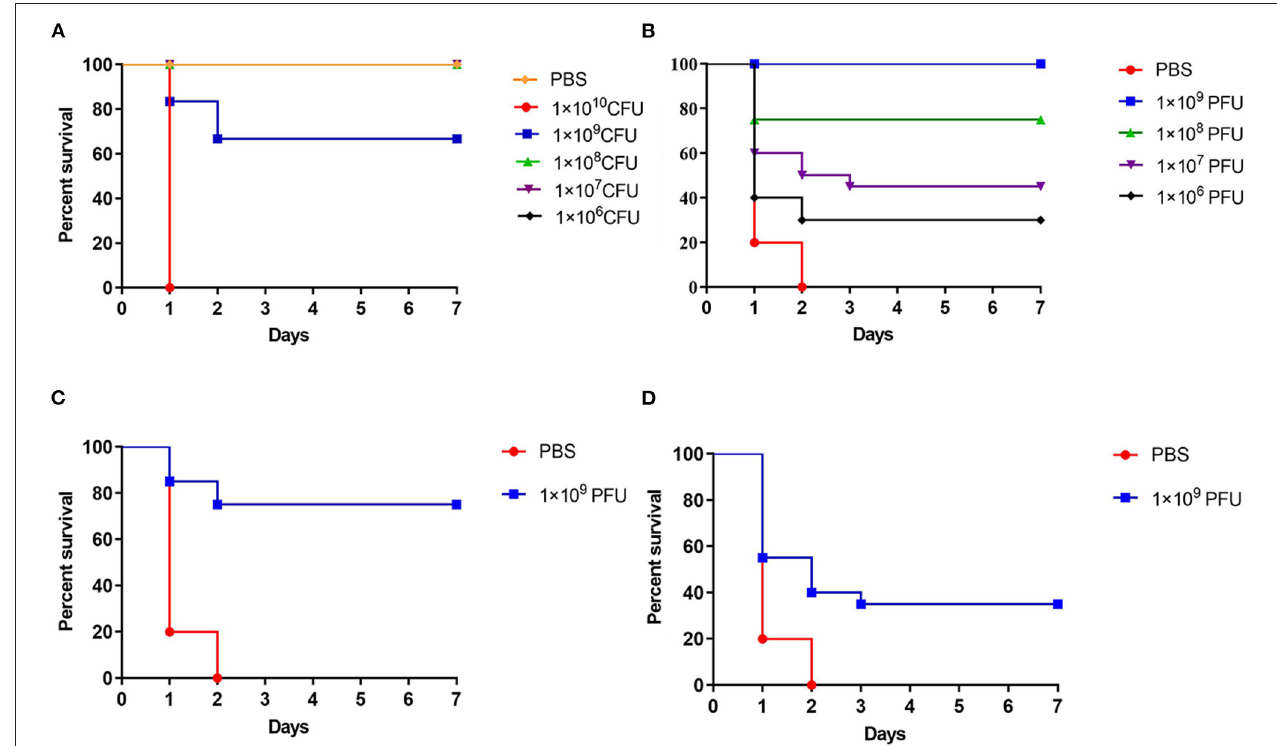
FIGURE 5 | The treatment effect of phage vB_CbrM_HP1 in vivo. (A) The minimum lethal dose (MLD) of Cbr-1. 10 6 , 10 7 , 10 8 10 9 and 10 10 CFU of Cbr-1 and PBS were introduced intraperitoneally. The fish were intraperitoneally injected with a 2 × minimum lethal dose (MLD) (2 × 10 9 CFU/fish) of Cbr-1. (B) One hour later, 10 6 , 10 7 , 10 8 and 10 9 PFU of vB_CbrM_HP1 were introduced intraperitoneally. (C) Twelve hours after injection of Cbr-1 (2 × 10 9 CFU/fish) and (D) 24h after injection of Cbr-1 (2 × 10 9 CFU/fish), 1 × 10 9 PFU phage of vB_CbrM_HP1 was introduced intraperitoneally. Control fish were administered PBS under identical conditions. The means and standard deviations are represented as points with error